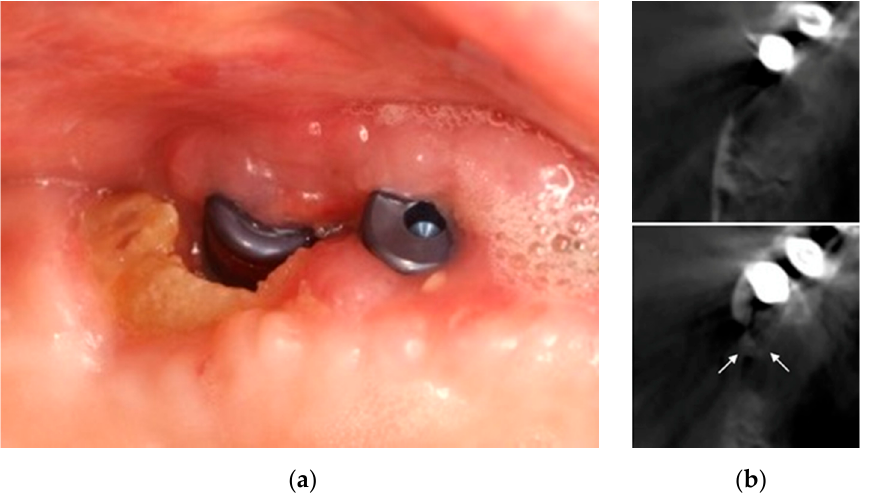
Figure 8. ( a ) Bone exposure at 30 days post implant-surgery. ( b ) White arrows: extension of bone necrosis at cross-sections at the crestal level and two millimeters towards apical on CBCT.